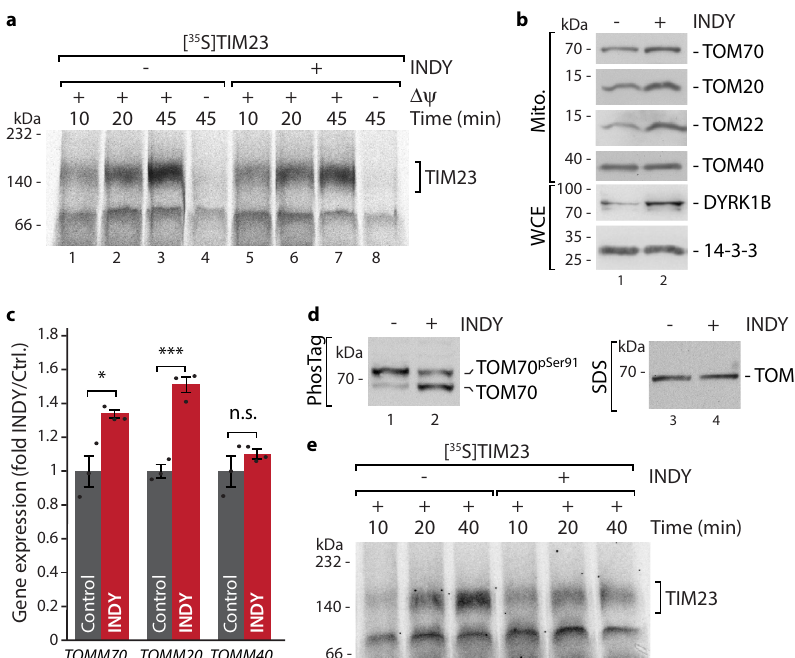
Fig. 3 DYRK1A inhibition elicits a protective transcriptional response resulting in remodeling of the import machinery. a Import of radiolabelled TIM23 precursor into isolated mitochondria from cells grown overnight in the presence or absence of INDY (10 µ M). Where indicated the membrane potential Δψ was dissipated prior to the import reaction. Samples were lysed in digitonin buffer and subjected to Blue Native PAGE. Imported protein was analyzed by standard SDS-PAGE and immunoblotting. 14-3-3, loading control. c Analysis of changes of indicated transcript levels upon DYRK1A inhibition